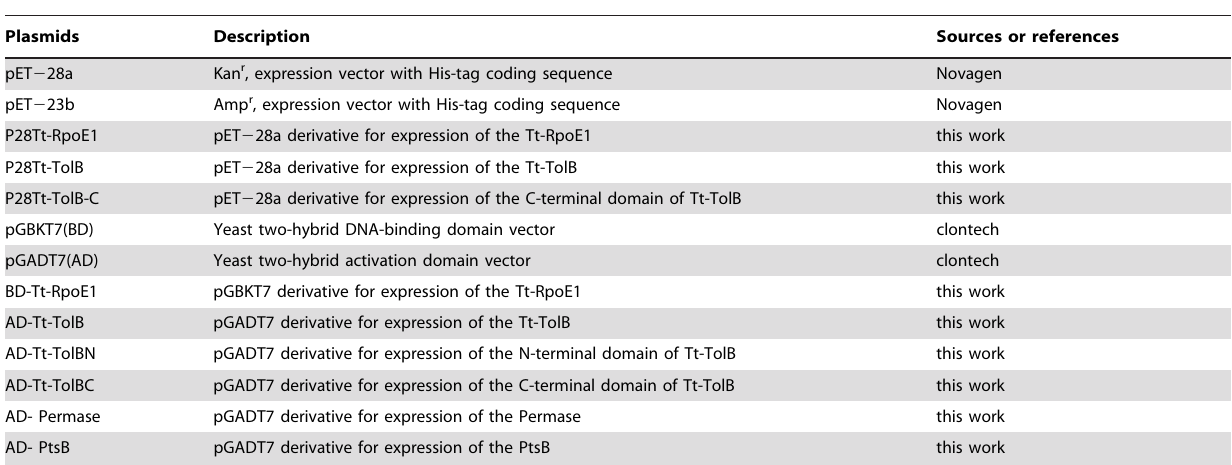
Table 1. Plasmids used in this